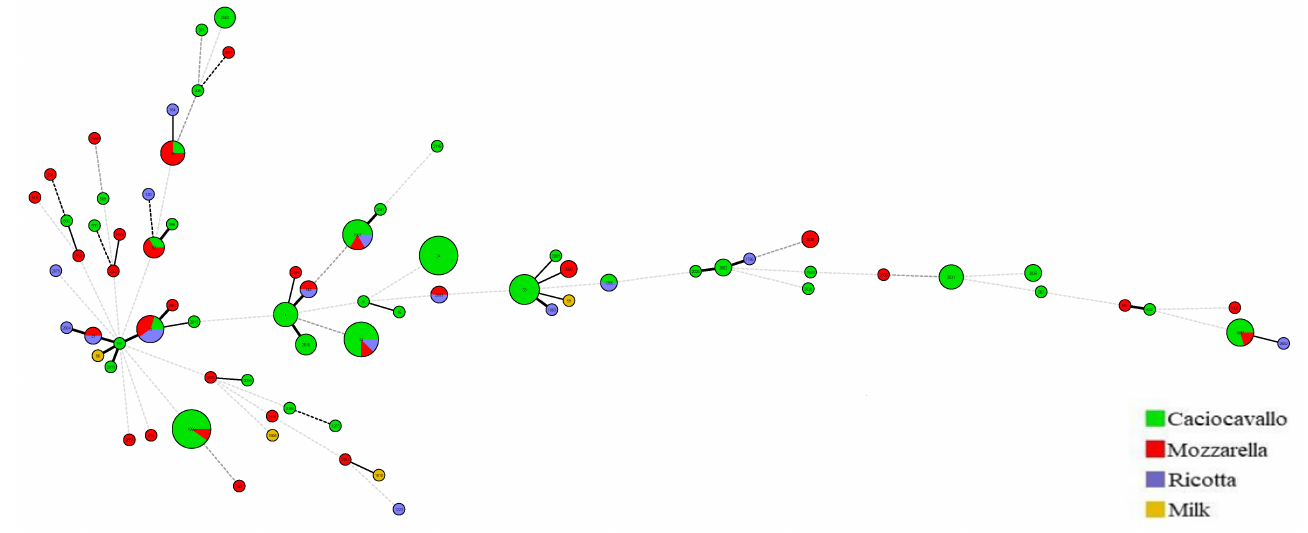
Figure 1. Minimum spanning tree analysis, using BioNumerics version 7.1, of the 139 B. cereus isolates based on allelic profiles of seven housekeeping genes. Each circle corresponds to a sequence type (ST) and the size of the circle is related to the number of isolates found with that profile. Each colour inside the circles represents the source origin of the strains (green, Caciocavallo ; red, Mozzarella ; indigo, Ricotta ; yellow, milk).